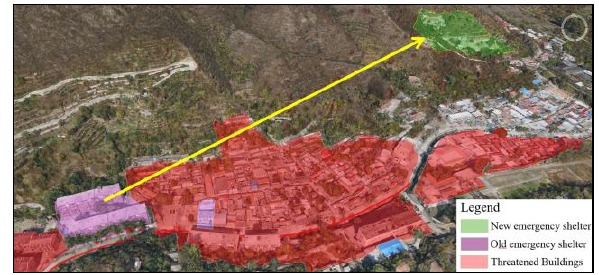
Figure 12 . Location relationship between threatened buildings and emergency shelter.